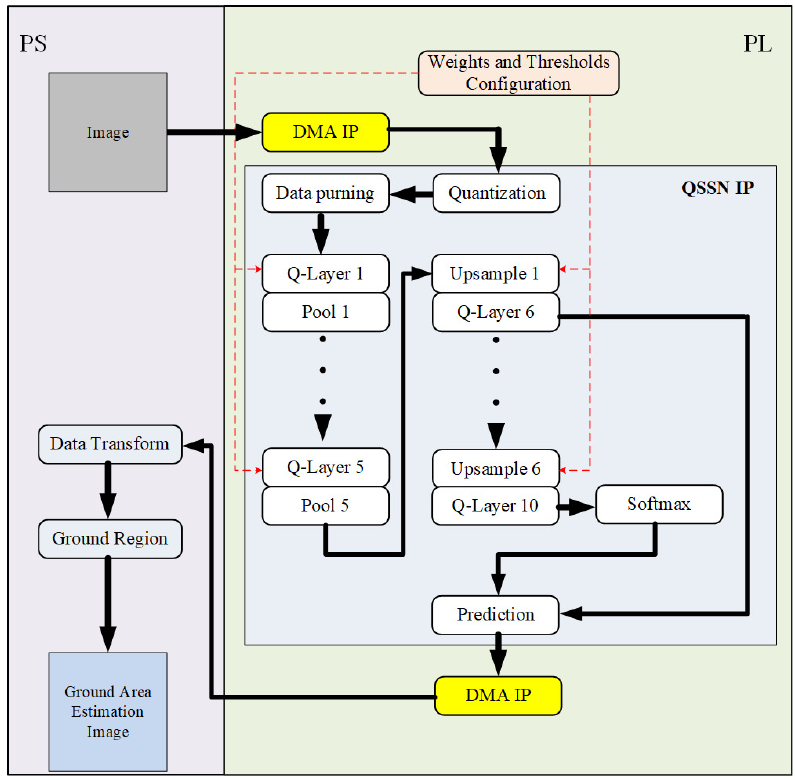
Figure 7. The proposed QSSN system architecture on the FPGA.